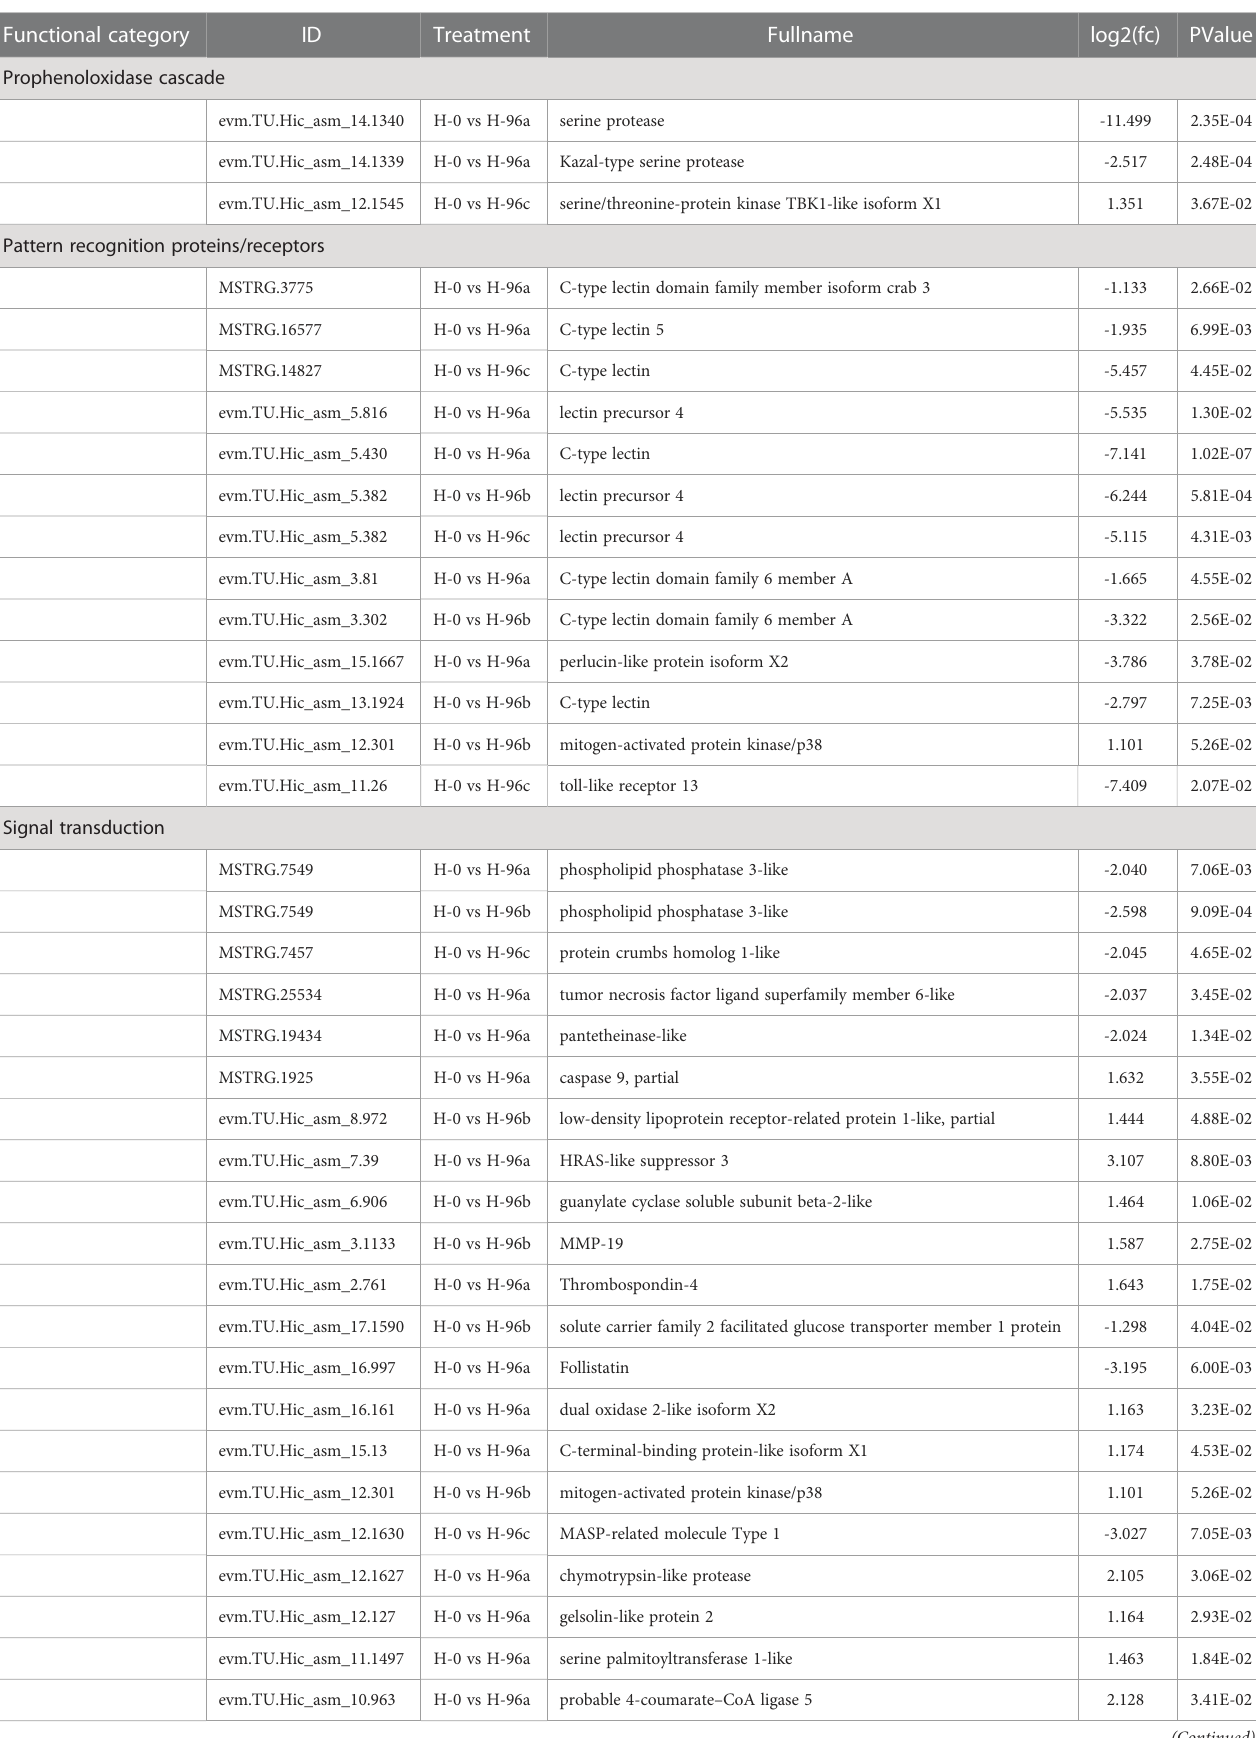
TABLE 3 Summary of differential expressed genes related to immune in transcriptome of C. sinensis . Functional